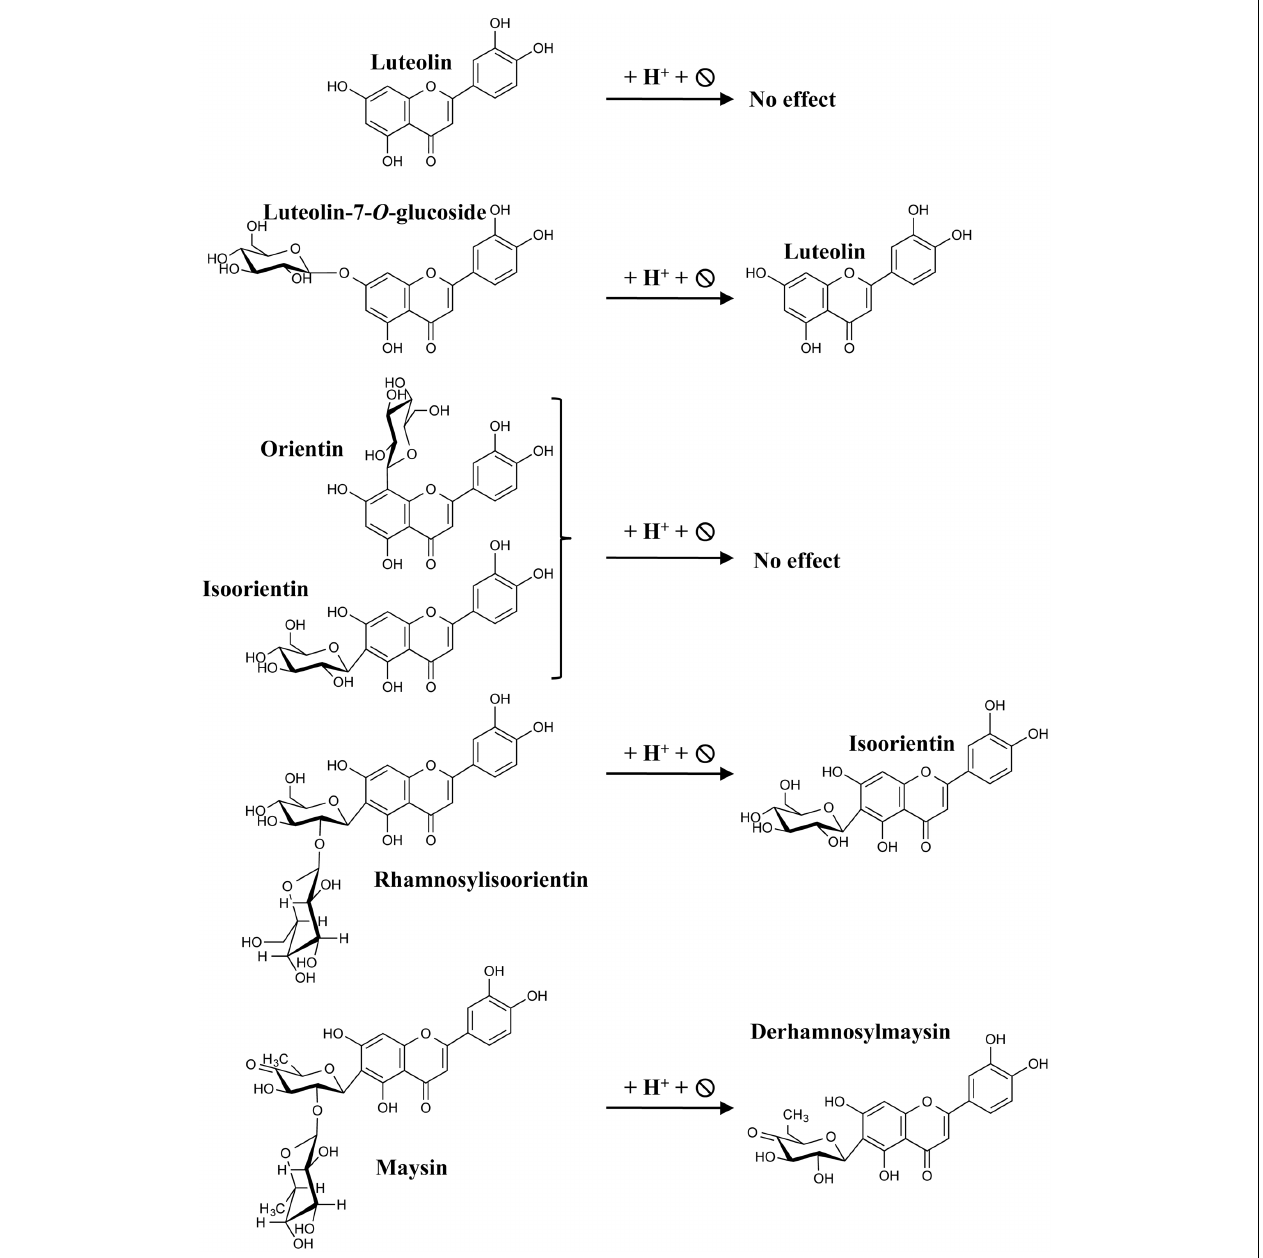
FIGURE 4 | Expected flavones resulting from acid hydrolysis. The scheme depicts the different flavones used in this study and their respective hydrolyzed derivatives expected for